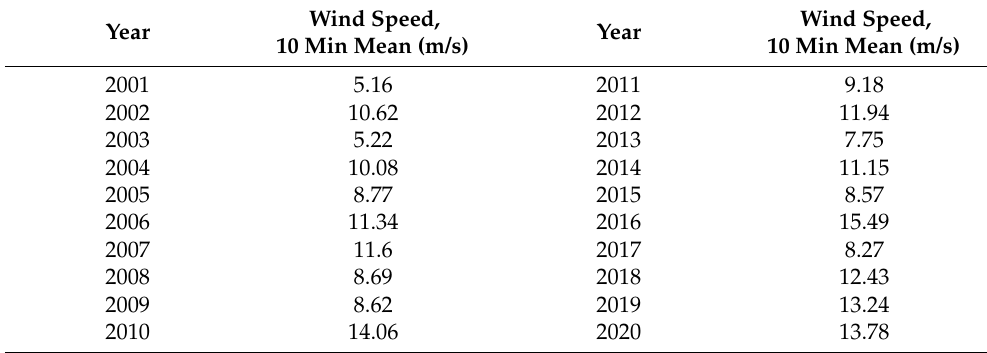
Figure 6. Schematic of the loads on the ULA system. Table 4. Wind-speed data at “A”